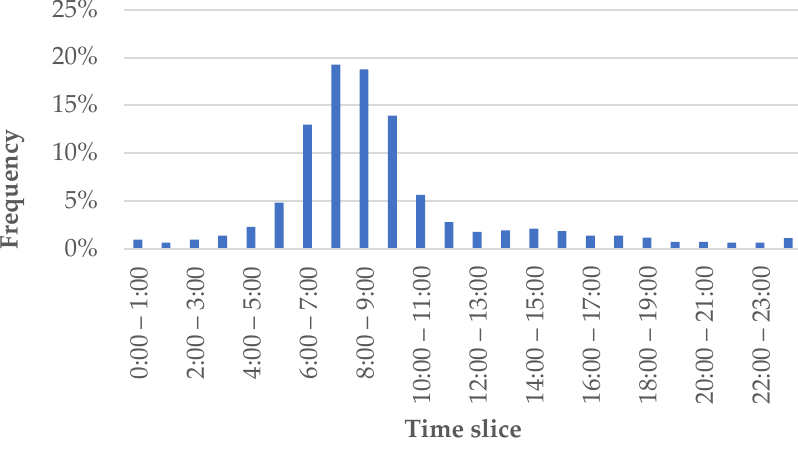
Figure 3. Tour distribution by time interval from